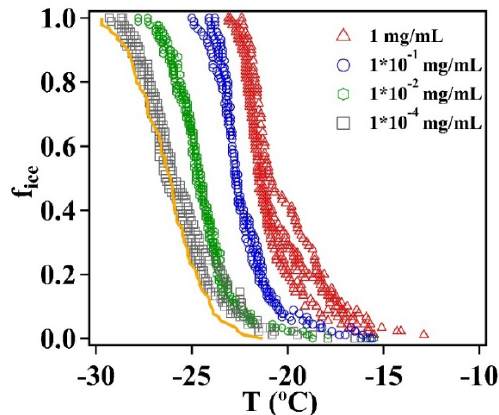
Figure 5. The frozen fraction ( ƒ ice ) of distilled water (orange curve) and illite NX suspensions with different mass concentrations (from 1 × 10 − 4 to 1 mg/mL), as measured in this work using the PKU-INA.